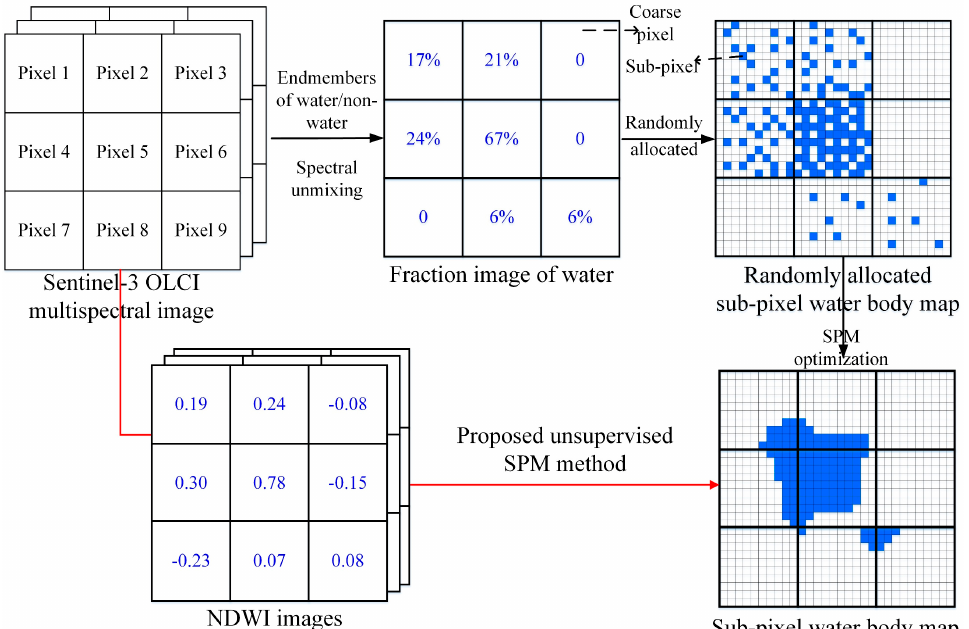
Figure 1. Illustration of sub-pixel water body mapping from Sentinel-3 OLCI image.